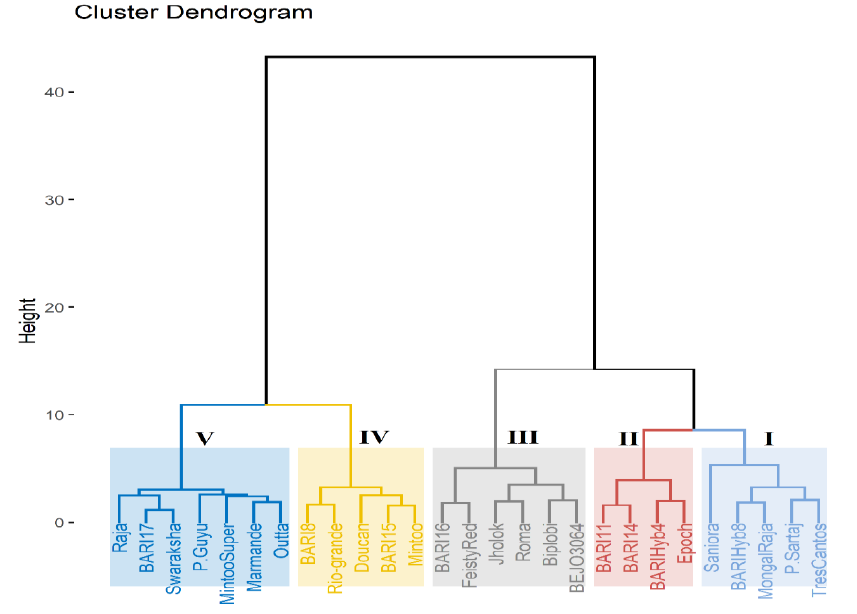
Figure 4. Dendrograph derived by Ward’s methods of cluster analysis for salt tolerance indices with 27 tomato genotypes at the vegetative stage under non-salinized control (S1) with 18.2 mM NaCl and salinized (S2) with 200 mM NaCl conditions during 2018–2019.